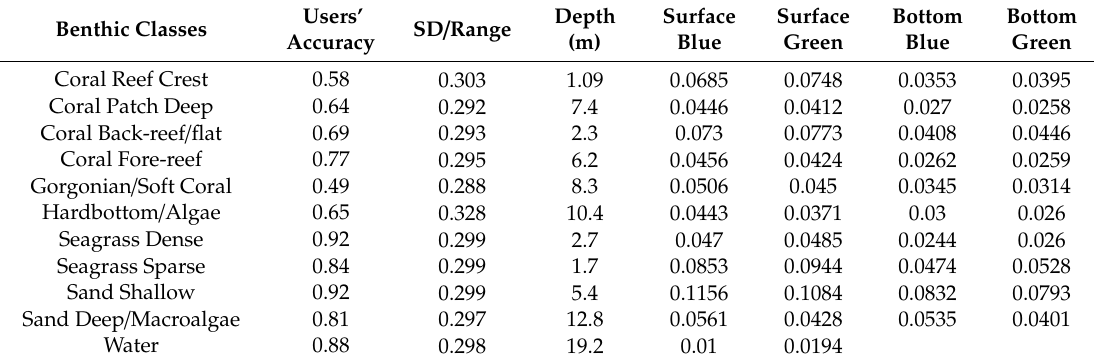
Table 3. Accuracy and mean physical values of di ff erent benthic compositions within the classified objects. SD / Range means standard deviation to range ratio calculated from Table 2.